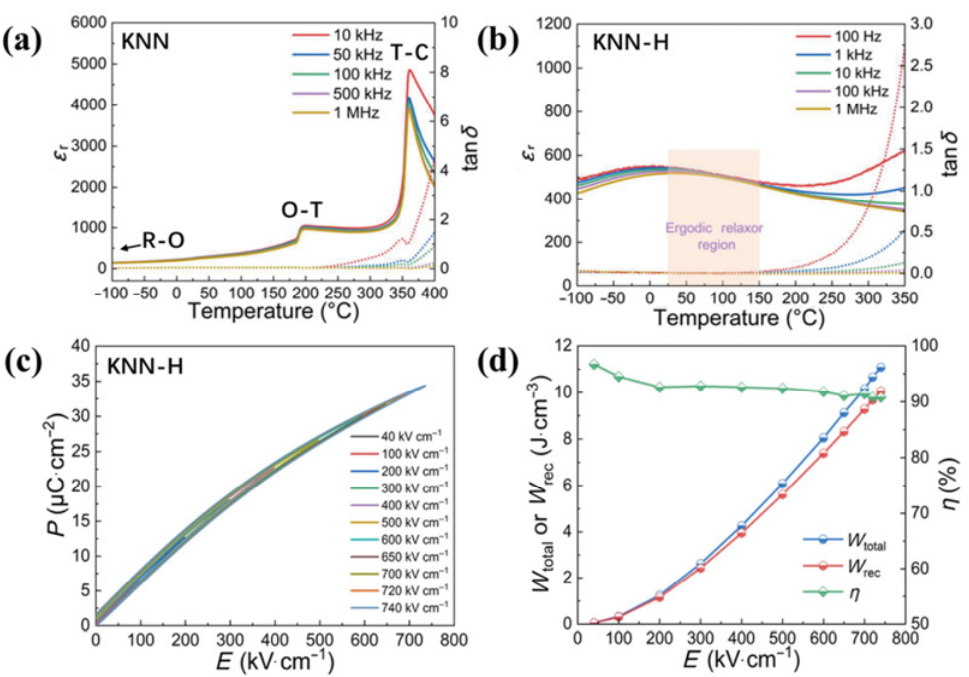
Fig. 7 Dielectric performance of (a) KNN and (b) KNN-H ceramics. (c) P – E loops and (d) energy storage performance of KNN-H ceramics. Reproduced with permission from Ref. [33], © The Author(s)